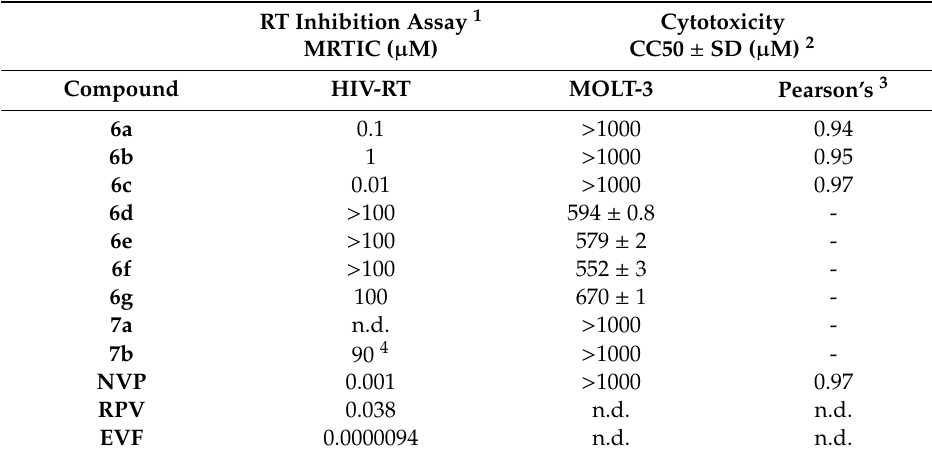
Table 1. Inhibitory activities against human immunodeficiency virus (HIV)-1 reverse transcriptase (RT) of pyrimidinylisoxazolidines and their